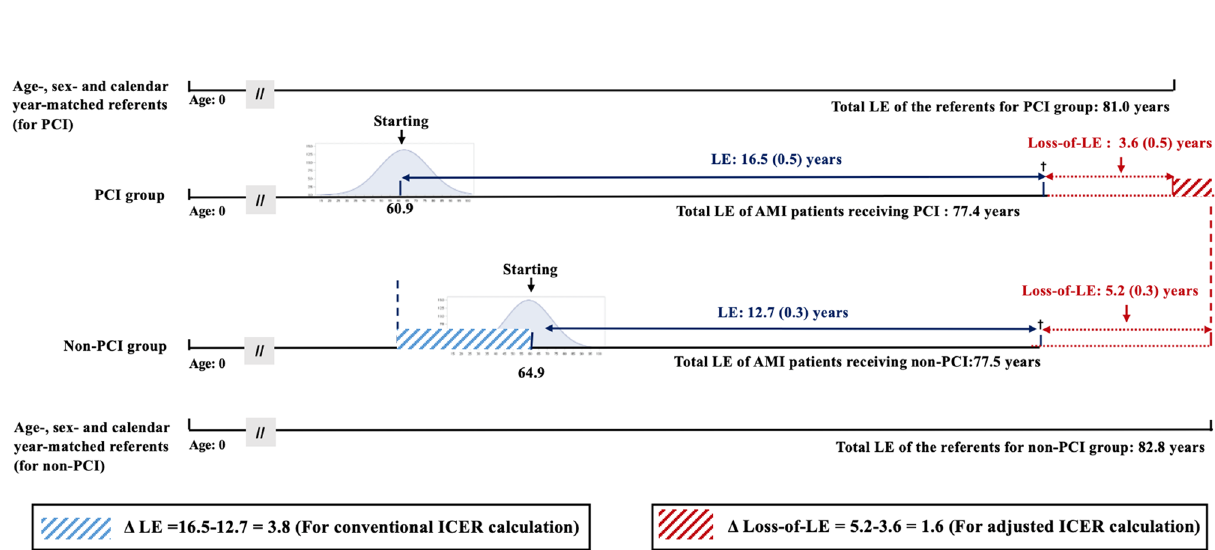
Figure 2. Illustration of the estimation of life expectancy (LE), total LE, loss of life expectancy (Loss-of-LE), and life-year saved for patients with acute myocardial infarction (AMI) receiving percutaneous coronary intervention (PCI) and non-PCI, and their corresponding referents matched with same age-, sex-, and calendar year of diagnosis. It indicates that comparison of loss-of-LE to obtain difference-in-differences as the lifetime health benefits for PCI would adjust for different distributions of age, sex, and different medical technology offered in different calendar years between the two